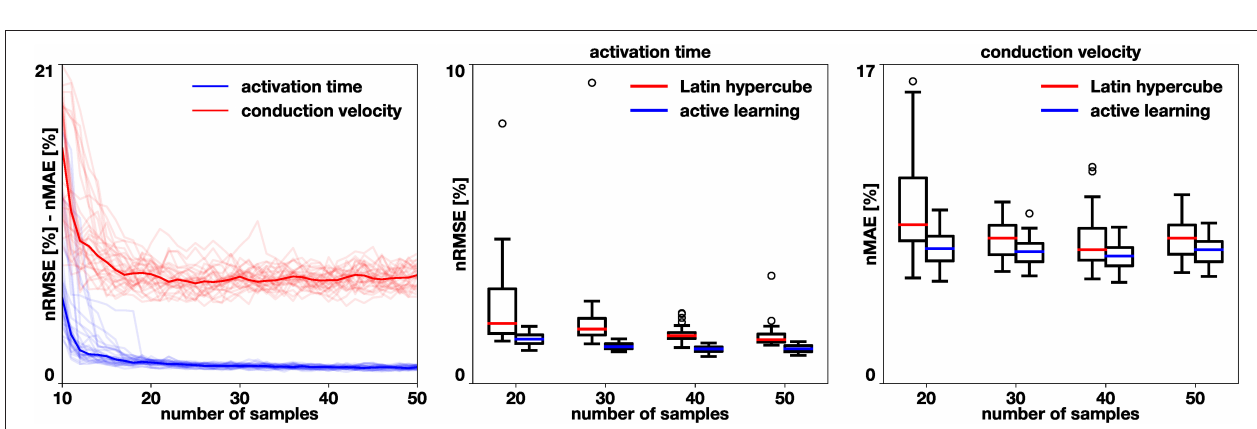
FIGURE 5 | Correlation of uncertainty and error. For the benchmark problem, trained with 30 samples, the computed entropy tends to be higher at regions where the error is higher and the points of maximum entropy and maximum error ( ⋆ ) are co-located. The black circles indicate the sampling locations.